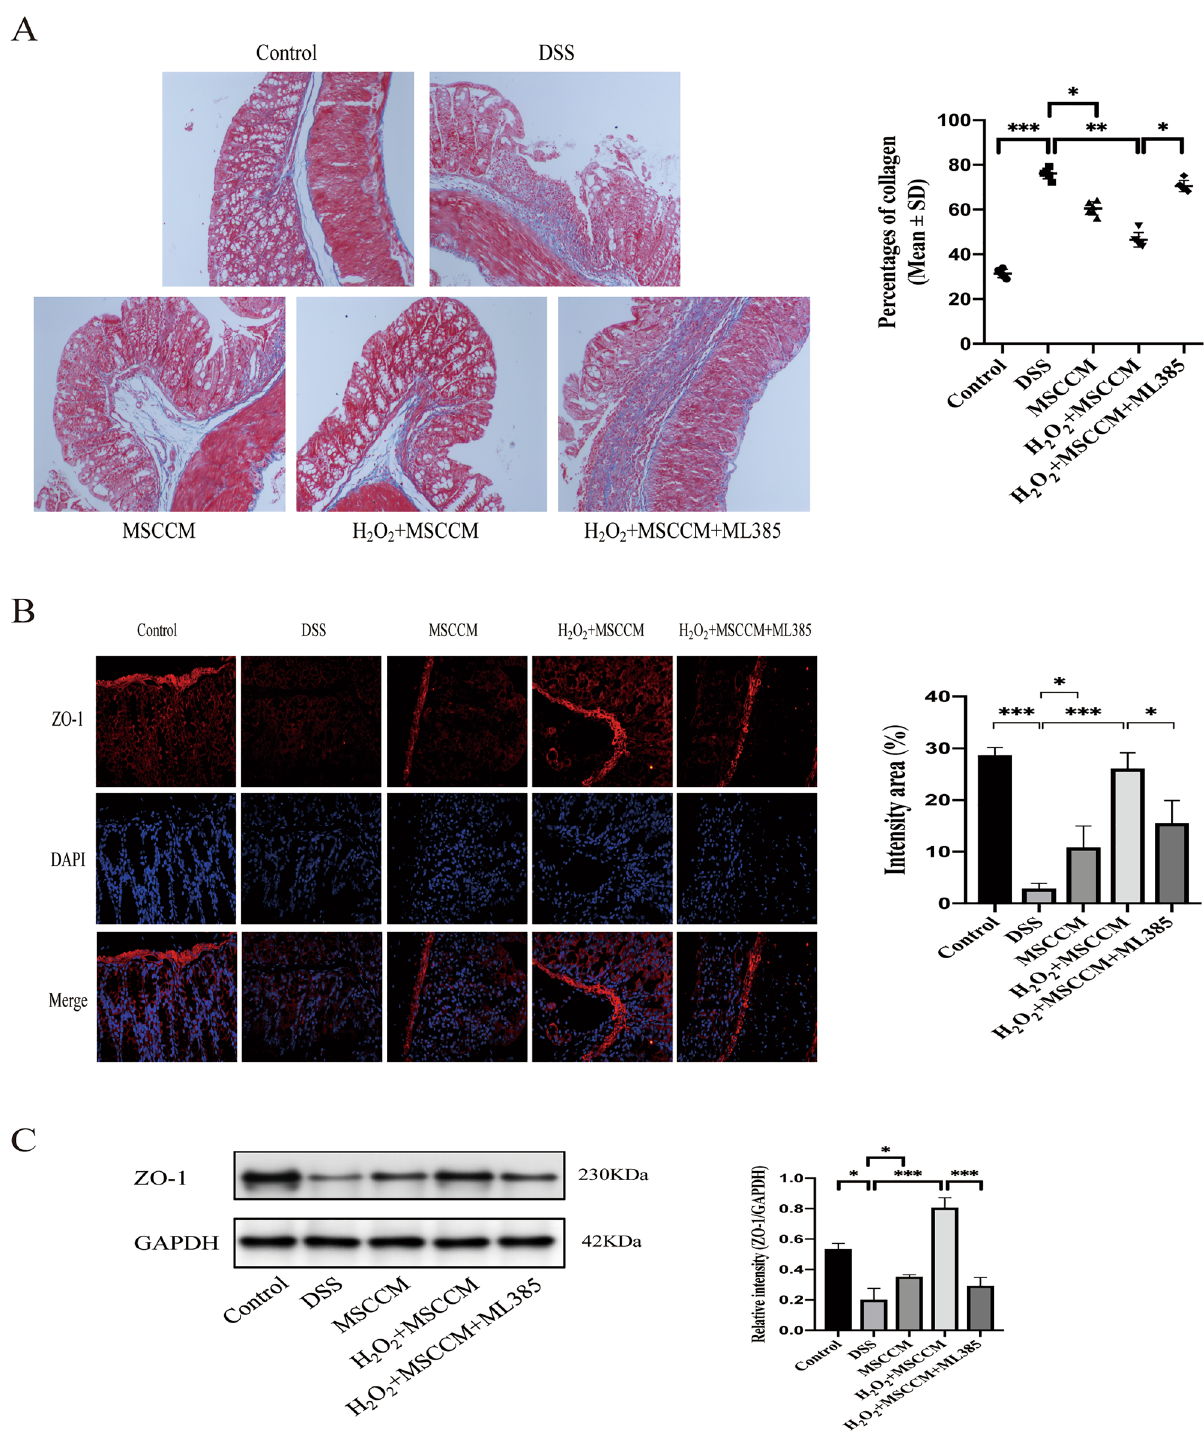
Figure 6. H 2 O 2 pretreated MSC-CM reduces intestinal mucosal barrier injury in colon tissue. ( A ) Masson staining assessed the collagen deposition in the colonic interstitium, the collagen area ratio was evaluated in bar graph. The insets are magnified images of the indicated rectangles. Magnification: × 100. Scale bar, 100 μm. Values are the means ± SD. n = 6 animals per group per time point. * P < 0.05, ** P < 0.01, and *** P < 0.001; ns no significance. ( B ) Sections of colonic tissues were immunostained for revealing ZO-1 proteins (red) as indicated. The slides were counterstained with DAPI (blue), and the images were captured using an inverted fluorescence microscope. Magnification: × 400. ( C ) Immunoblotting assay determined the abundance of ZO-1 proteins. Semiquantitative analysis of proteins of interest by densitometry assay. The data are expressed as the mean ± SD. * P < 0.05, ** P < 0.01, and *** P < 0.001; ns no